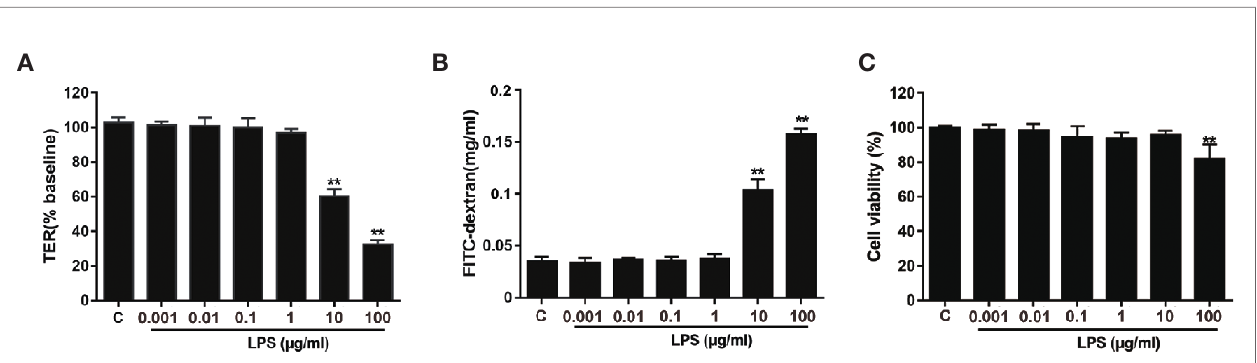
FIGURE 1 | Effects of LPS on TER and FD4 permeability in Caco-2 monolayers. Caco-2 cells grown on transwell inserts were treated with various concentrations (0.001 − 100 m g/ml) of LPS for 24 h. TER (A) and FD4 fl ux (B) across cell monolayers were measured. (C) The CCK-8 assay was used to detect the viability of cells infected with LPS (0.001, 0.01, 0.1, 1, 10, or 100 m g/ml). Data are presented as means ± SD from three independent experiments. Statistical analyzed using the unpaired t test. * P < 0.05, ** P <